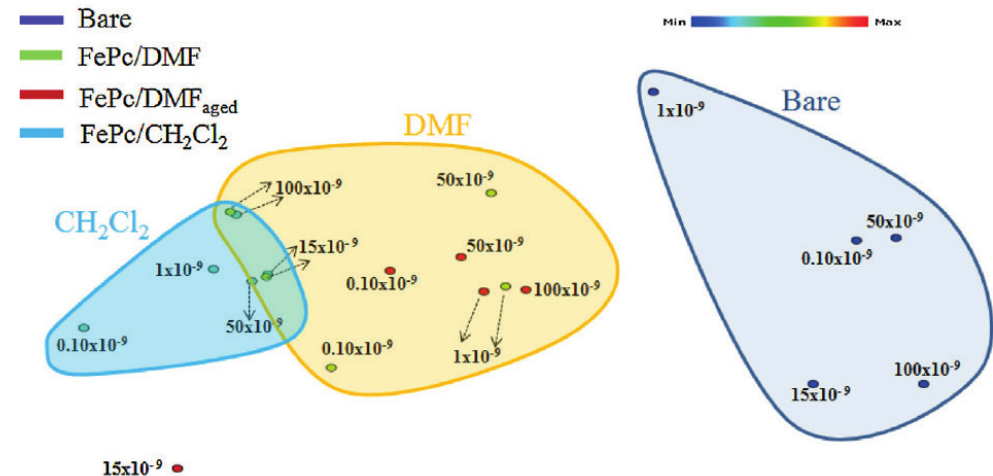
Figure 3 - IDMAP projection obtained using capacitance measurements in the presence of atrazine for the FePc fi lms in diff erent